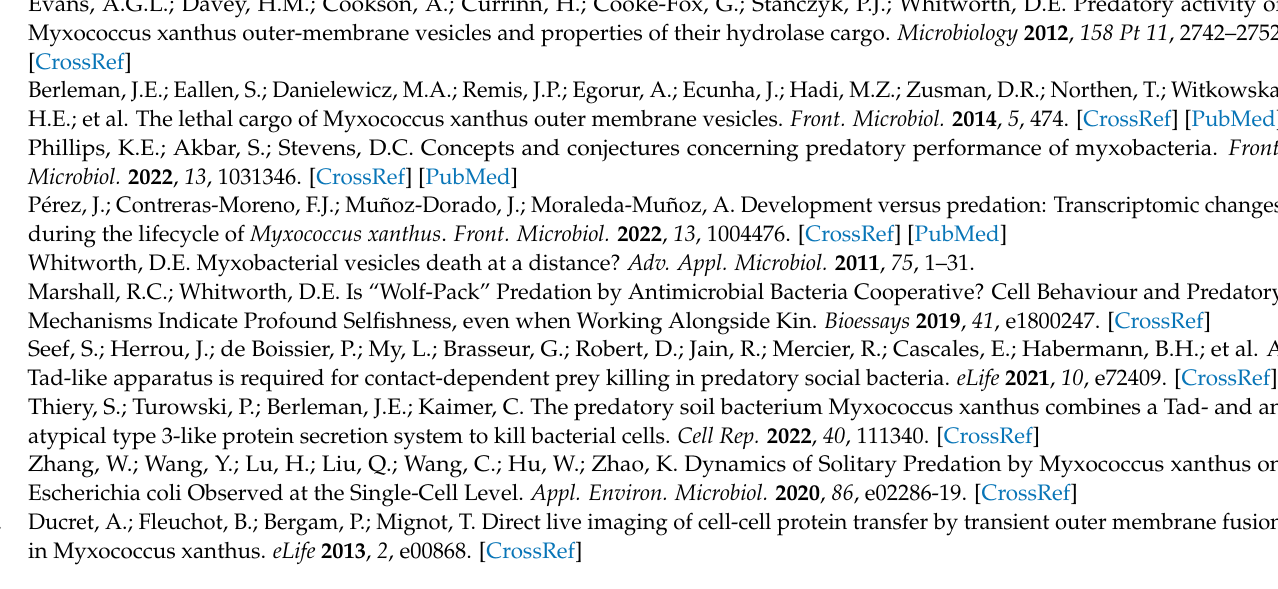
Figure S5: behaviour of myxobacteria on dead and lysed prey cells of Xanthomonas campestris ; Figure S6: behaviour of myxobacteria on dead and lysed prey cells of Clavibacter michiganensis ; Figure S7: behaviour of myxobacteria on dead and lysed prey cells of Ustilago maydis